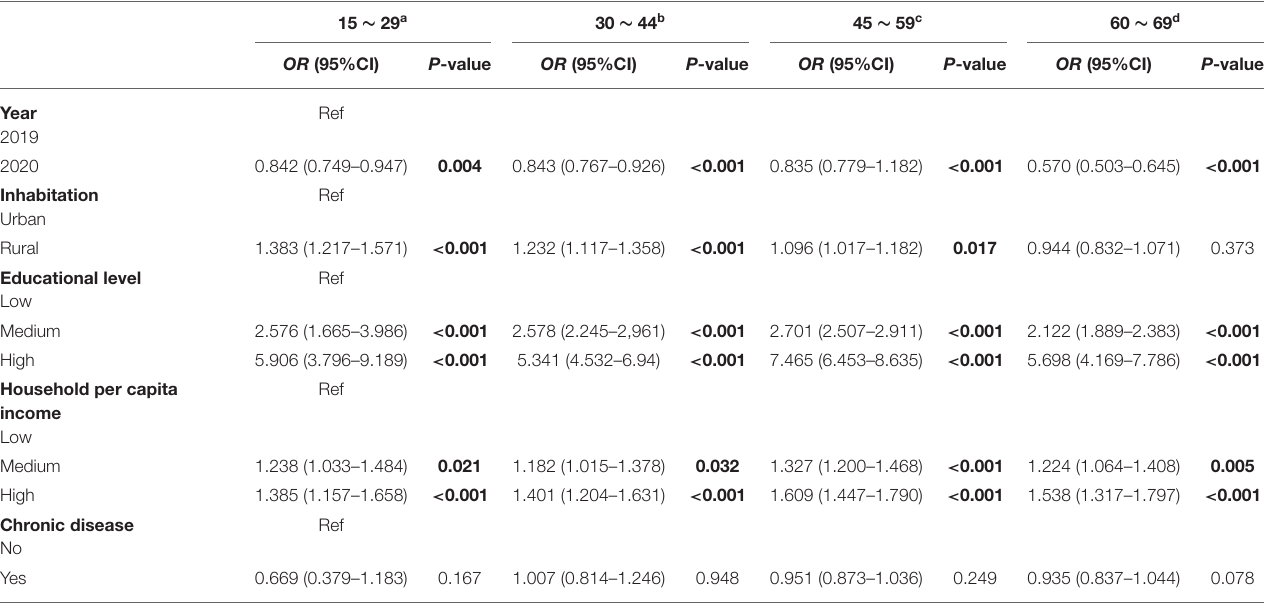
TABLE 2 | Factors associated with health literacy* stratified by age groups-results of the Logistic